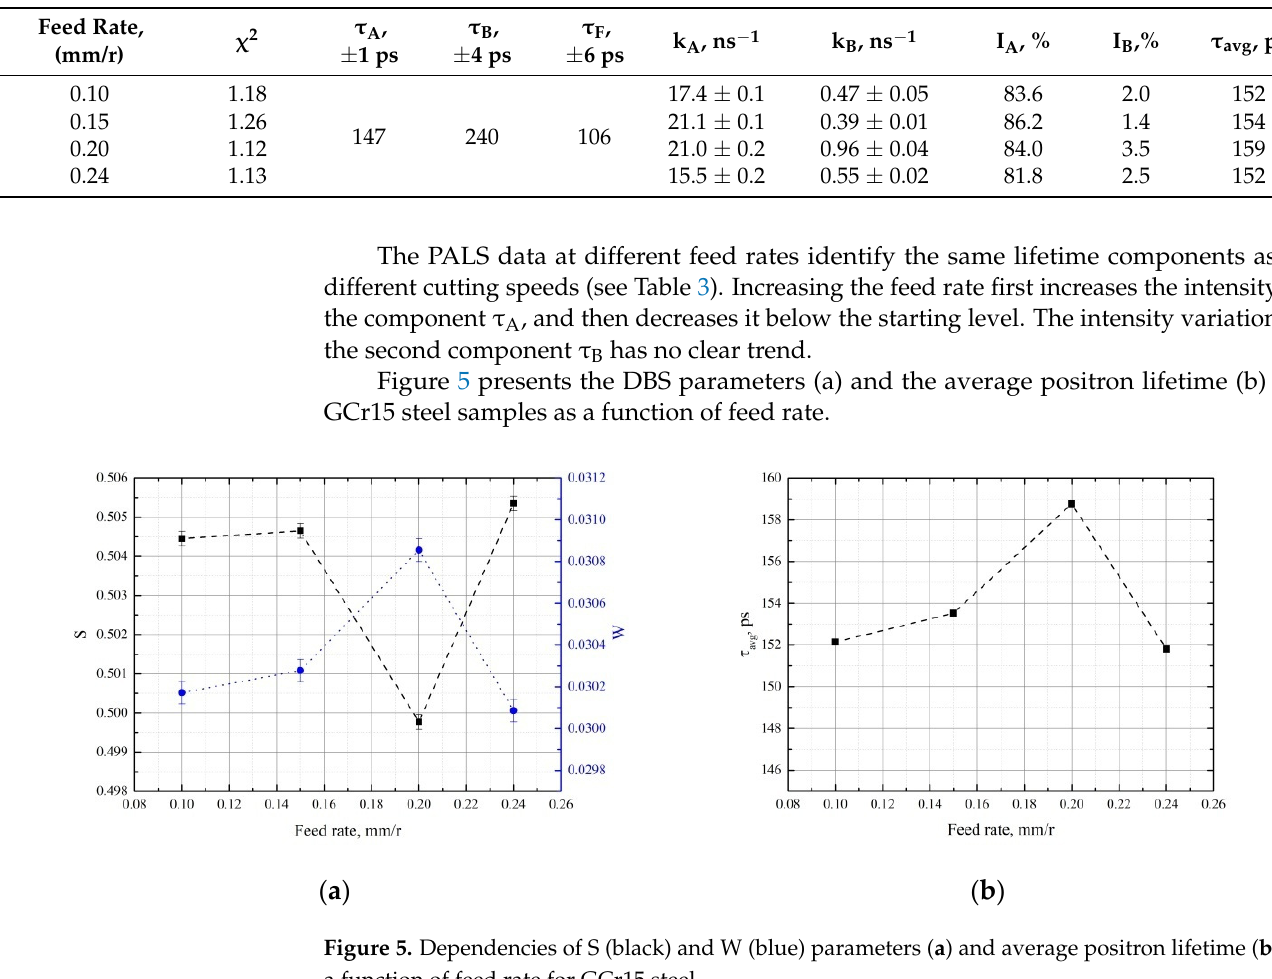
( b ) Figure 6. DBS-VEP depth profile of the S ( a ) and W ( b ) parameters for the white layer in GCr15 samples with different feed rates. Increasing the feed rate from 0.1 to 0.2 mm/r does not lead to observable changes in the S and W parameters throughout the range of implanted positron energies. However, at f = 0.24 mm/r, a decrease in the S parameter at depths up to 200 nm is observed. This may indicate an increase in martensitic phase content in this region. 3.3. Influence of the Cutting Depth The dependence of the PALS experimental results on the cutting depth for GCr15 samples is shown in Table 5.